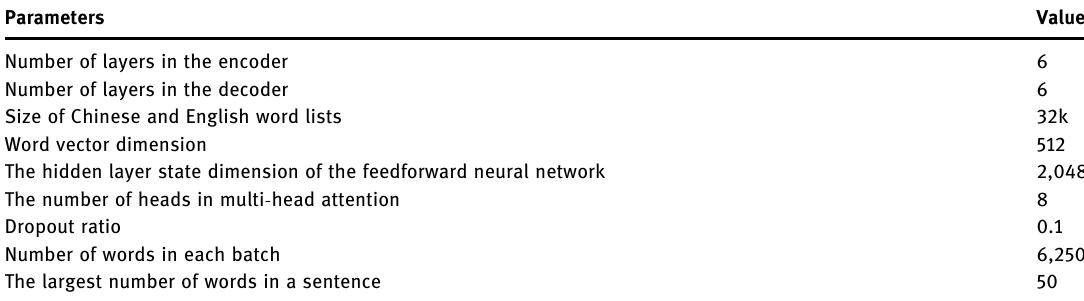
Table 1: Parameters of the Transformer model Parameters Value Number of layers in the encoder Number of layers in the